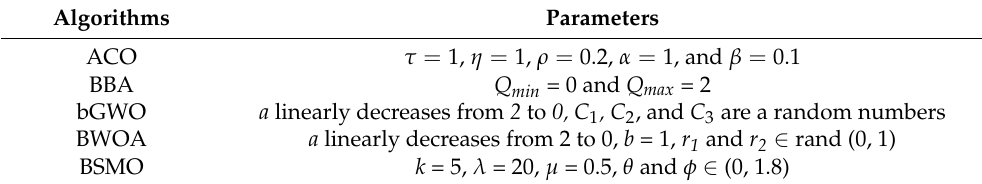
Table 2. Parameters